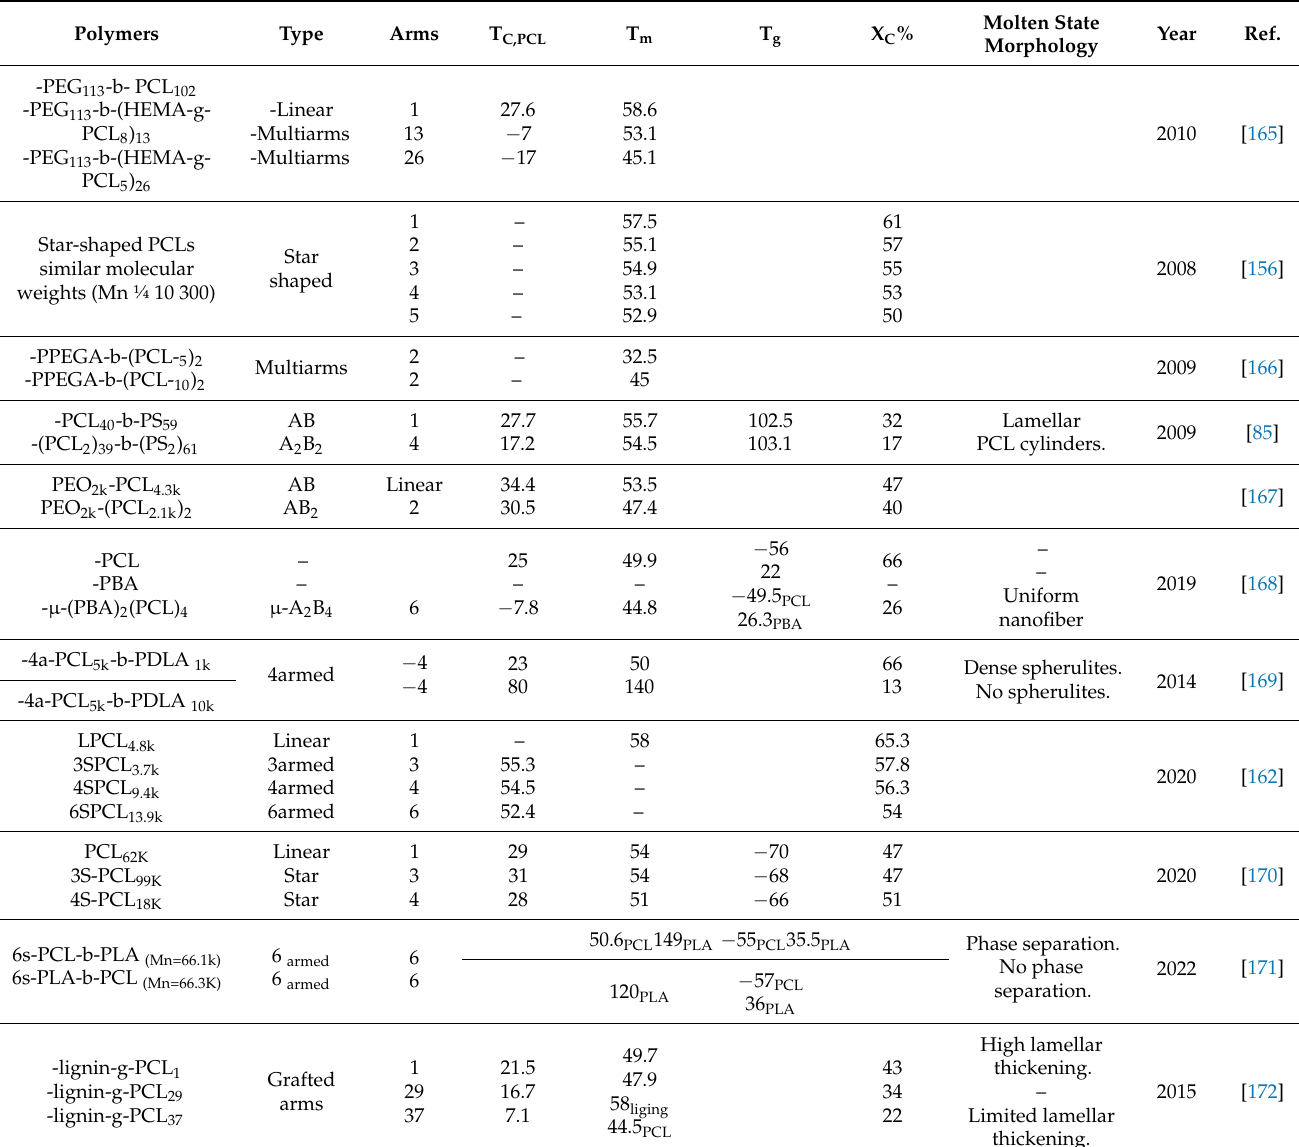
Table 2. The variation of thermal and crystallinity characteristics in accordance with the macromolec- ular architectures of PCL-based